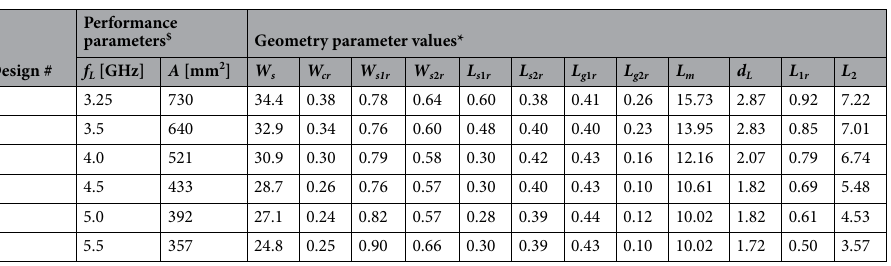
Table 1. Trade-off designs for the CP antenna of Fig. 4: geometry parameter values. $ f L and A stand for the lower end of the operating bandwidth, and the footprint area, respectively. *Absolute parameters in mm; relative parameters (ending with subscript r ) unit-less.